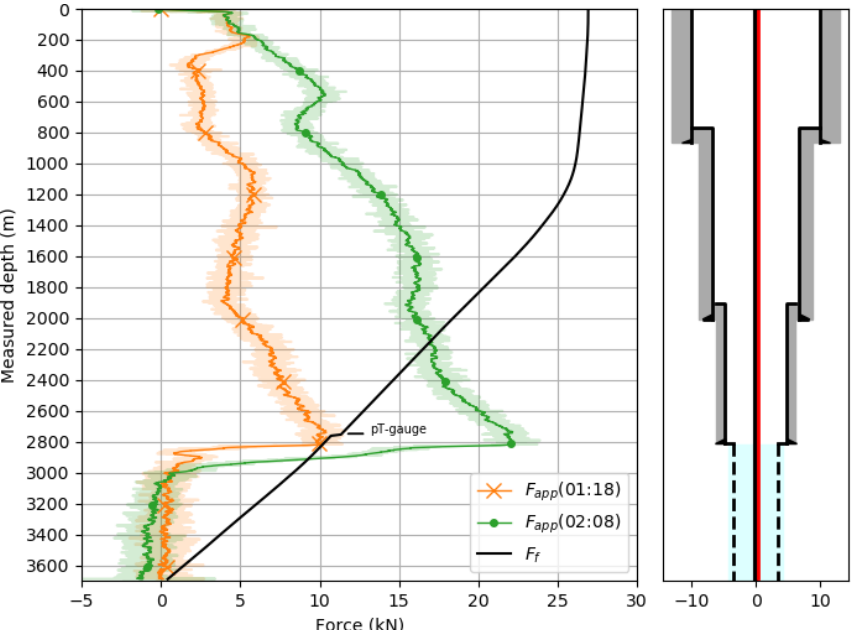
Figure 10. Comparison of static friction F f with applied forces F app from thermal contraction of the rod within the first 72min of cold-water fluid injection. The pale colors in F app originate from measured DTS data, and the solid lines are constructed by a moving average over 15m.